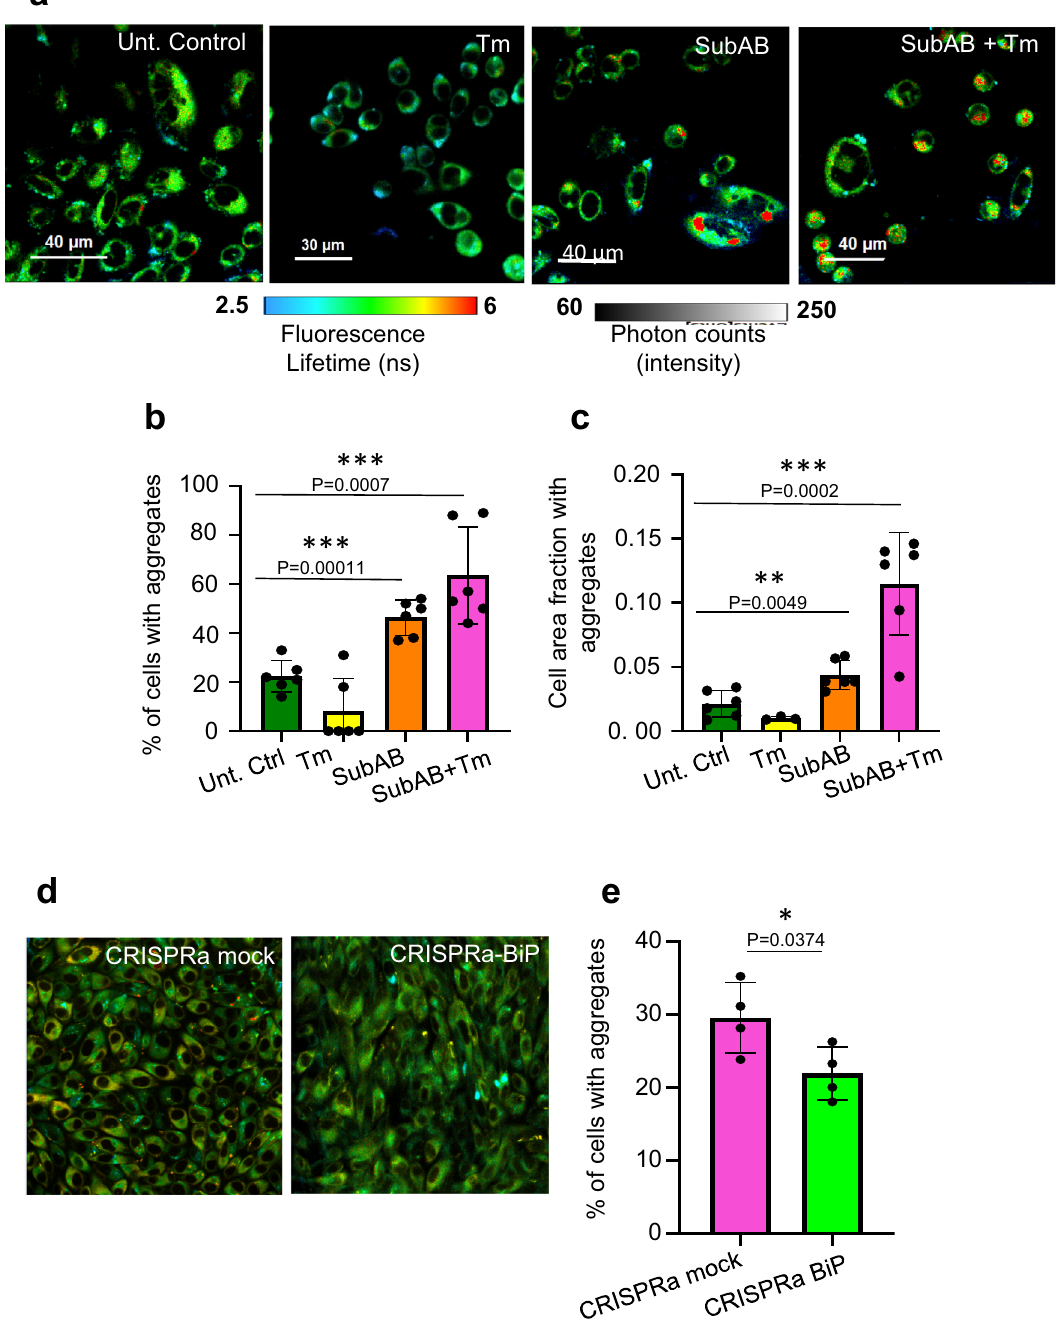
Fig. 4 HT-aggr disaggregation by BiP in cells. a FLIM images of live CHO-K1 cells stably expressing HT-aggr ER (K73T), untreated, treated with subtilase cytotoxin AB (SubAB at 0.4 μ g/mL) or with SubAB plus tunicamycin (Tm at 0.5 µ g/mL) for 24h, representative images from three independent experiments. b Quanti fi cation of the relative number of cells with FLIM-detected aggregates in images as in ( a ). c Quanti fi cation of the fraction of the cell area occupied by aggregates in images as in ( a ). d FLIM images as in ( a ) for cells transfected with CRISPRa vectors with speci fi c gRNA targeting BiP promotor or with unspeci fi c sequence (mock), representative images from two independent experiments, see Supplementary Fig. 11 for CRISPRa validation. e quantitation of aggregates as in ( b ). Mean± SEM, n = 6, 6, 4 independent fi elds of view as in Fig. 3 for ( b , c , e ), respectively. * P < 0.05; ** P < 0.01; *** P < 0.001; **** P < 0.0001, unpaired T test Confocal microscopy, FLIM, fast 3D FLIM and image analysis . Cells were SYBR ™ Green Master Mix and QuantStudio ™ 5 (Applied Biosystems). Primer imaged in coverslips bottom dishes in complete medium with a laser confocal sequences (Fw and Rev, respectively) were: BiP ( Hspa5 ), 5 ′ -GTGCA- microscopy system (LSM 710, Carl Zeiss) equipped with an Argon laser and a GAAACTTCGTCGTGA-3 ′ and 5 ′ -TTCTGGACTGGCTTCATGGT-3 ′ ; Gapdh , Plan-Apo-chromat 60x oil immersion lens (NA 1.4) coupled to a microscope 5 ′ -GACATGTCGCCTGGAGAAAC-3 ′ and 5 ′ -CACTGTTGAAGTCGCAGG incubator, maintaining standard cell culture conditions. FLIM images of Halotag AG-3 ′ . Relative gene expression of BiP between the mock and the CRISPRa labelled with the P1 fl uorophore 12 (see excitation/emission spectra of P1 in PBS transfected cells was calculated using the delta-delta Ct method.